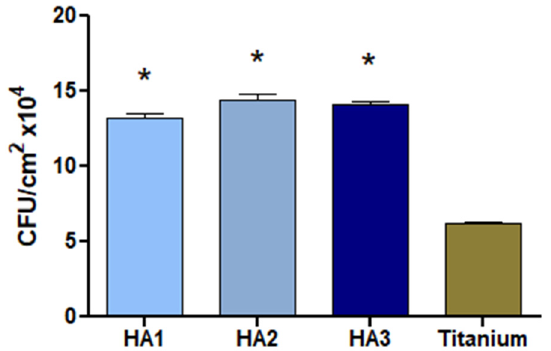
Figure 9. Numbers of S. aureus cells washed out from HA coatings (HA1, HA2, HA3) and titanium alloy (control). CFU = colony forming unit. Data are presented as mean ± standard deviation (SD) of three separate experiments (six replicates for each experimental variant). Statistical significance: * p < 0.05; * HA coatings vs. titanium.